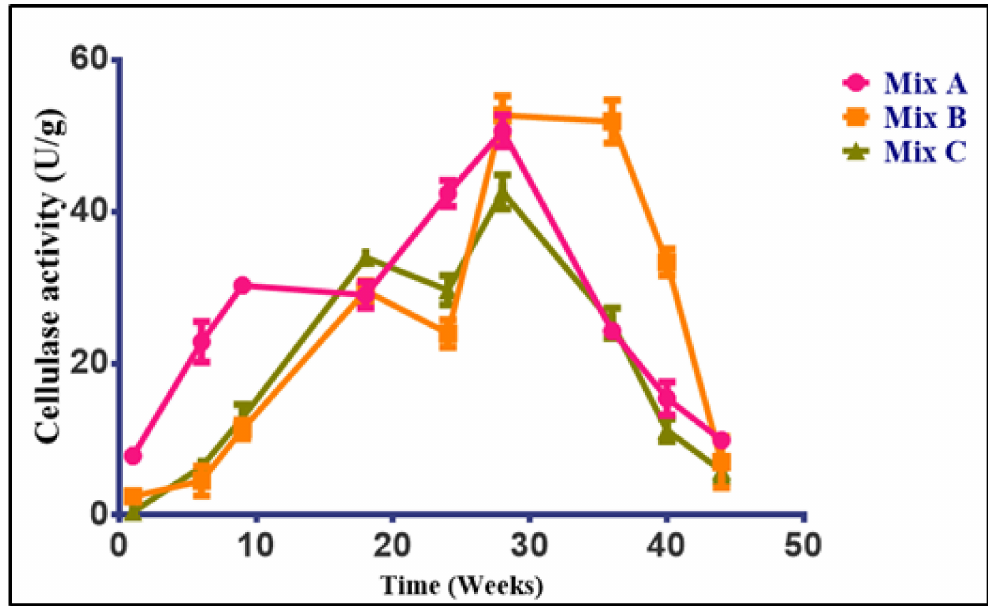
Figure 7. Changes in cellulose activity during the composting of di ff erent